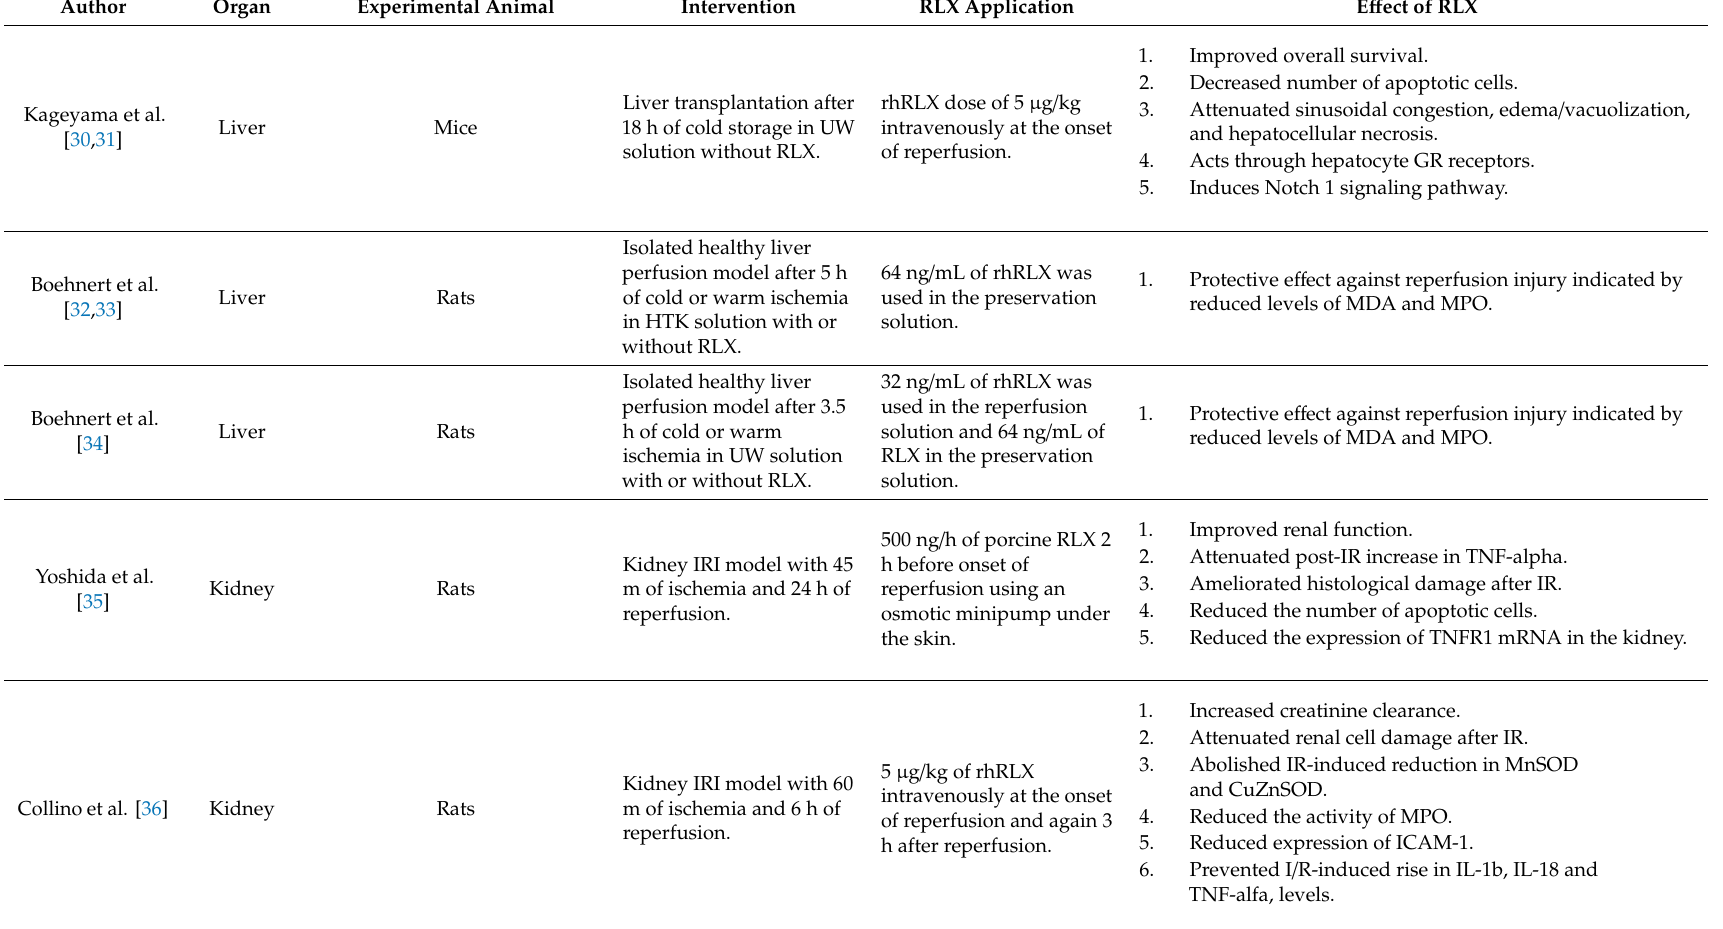
Table 1. Relaxin application in preclinical